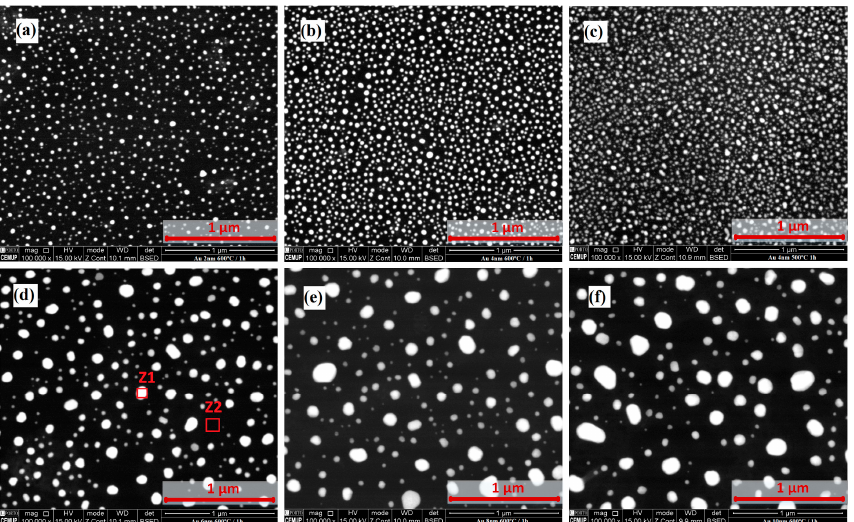
Figure 3. Scanning Electron Microscope (SEM) photograph of samples annealed at 500 and 600 ◦ C for 1 h for 2 to 10 nm tick Au thin films: ( a ) 2 nm/600 ◦ C, ( b ) 4 nm/600 ◦ C, ( c ) 4 nm/500 ◦ C, ( d ) 6 nm/600 ◦